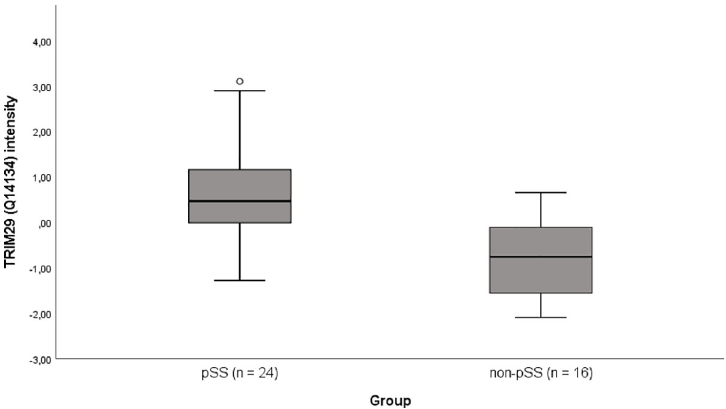
Fig 2. Box plot of salivary TRIM29 in pSS and non-pSS. Box plot illustrating the salivary TRIM29 intensity in the two groups after subtracting the median value across samples from individual samples. The group difference was 1.54, indicated by mean intensity of pSS–non-pSS. Mean intensity in pSS = 0.73 and non-pSS = -0.81.